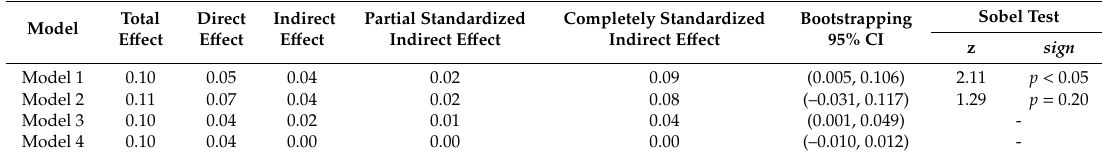
Table 3. Models e ff ect